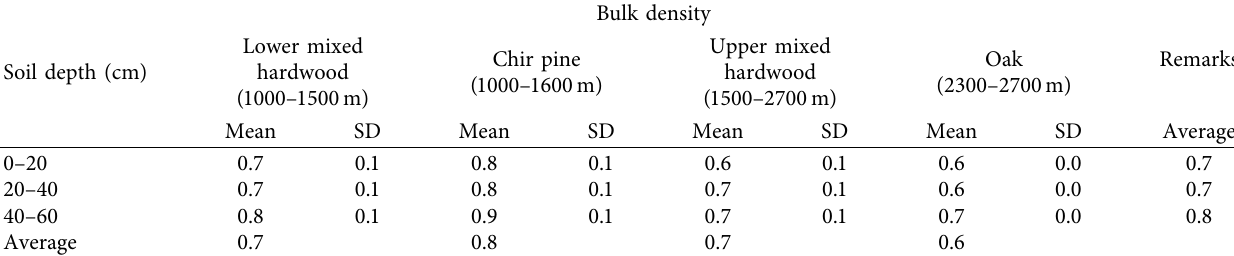
Table 1: Bulk density (gm/cm 3 ) of soil at different depths in different forest types.